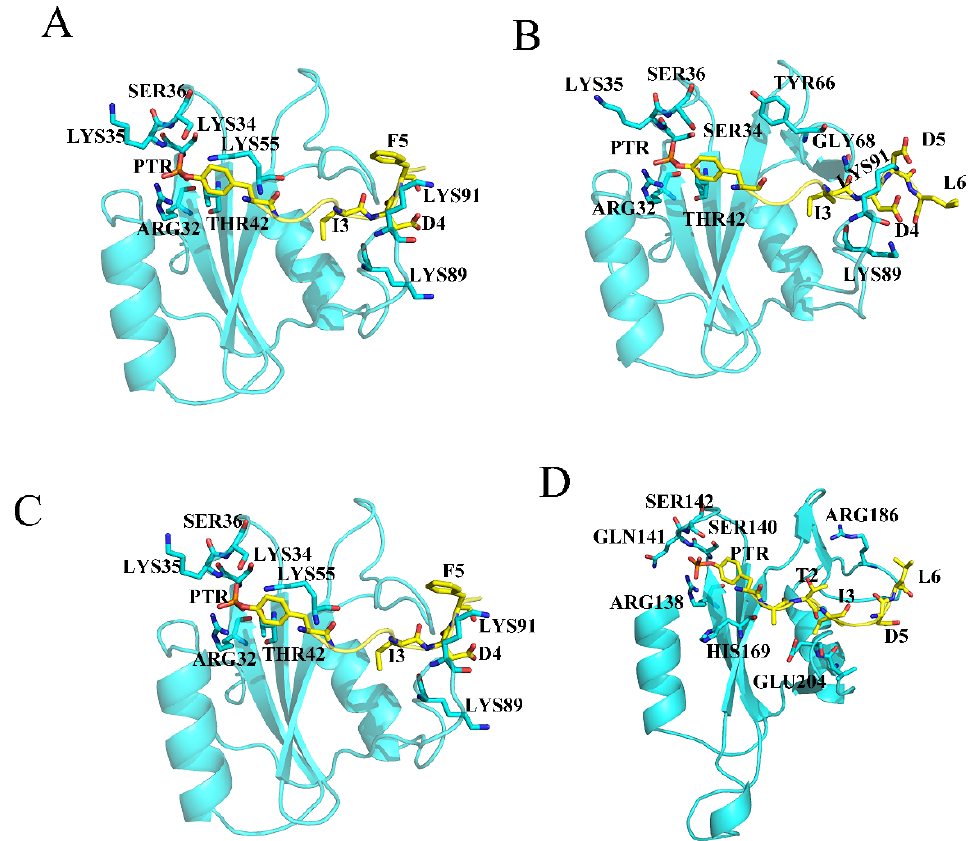
Figure 3. The binding details of systems EPIYA-D-N ( A ), EPIYA-C-N ( B ), EPIYA-D-N ( C ), and EPIYA-C-C ( D ). The SHP2 protein is shown in blue, and the peptides EPIYA are shown in yellow.